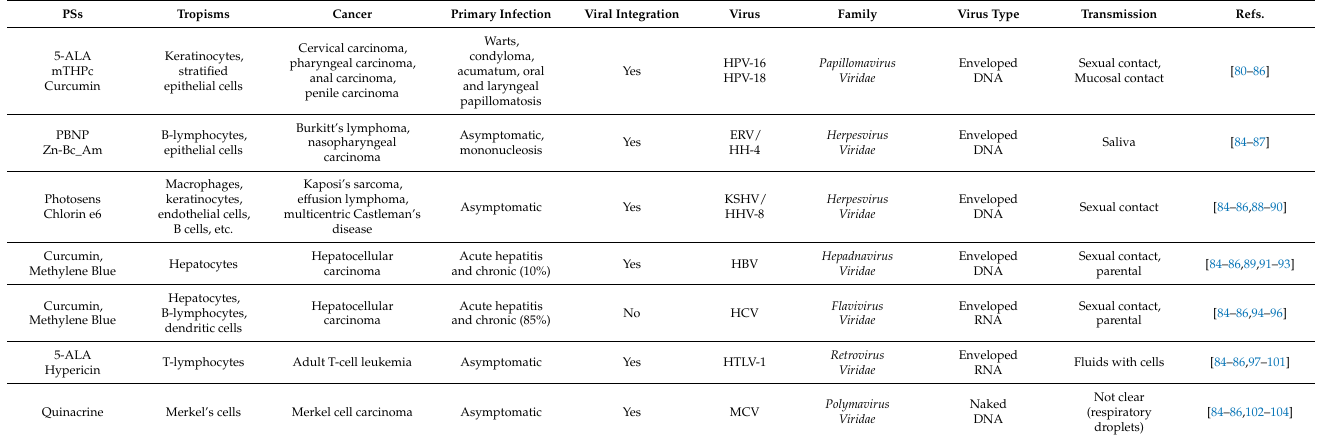
Table 1. The PS-mediated PDT/PDI and characteristics of oncogenic